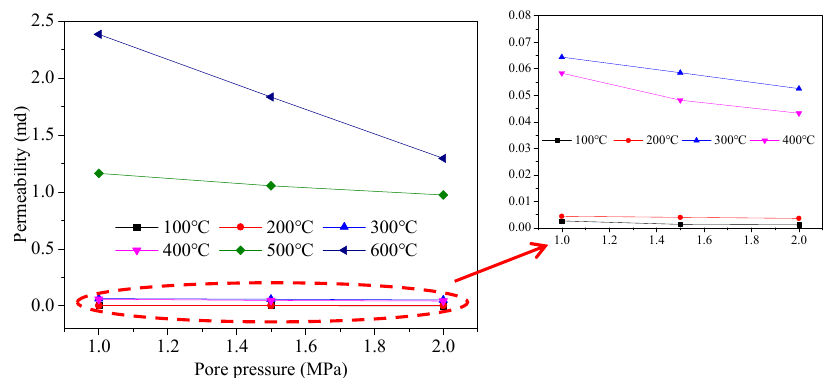
Figure 11. Correlation between permeability and pore pressure.